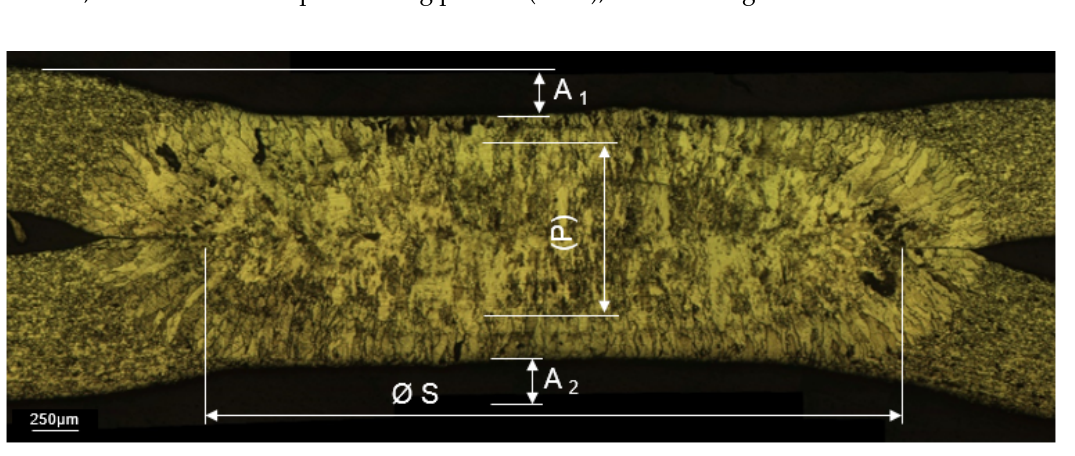
Table 5. Dimensions of the spot-welded joints by the macrography tests (mm).